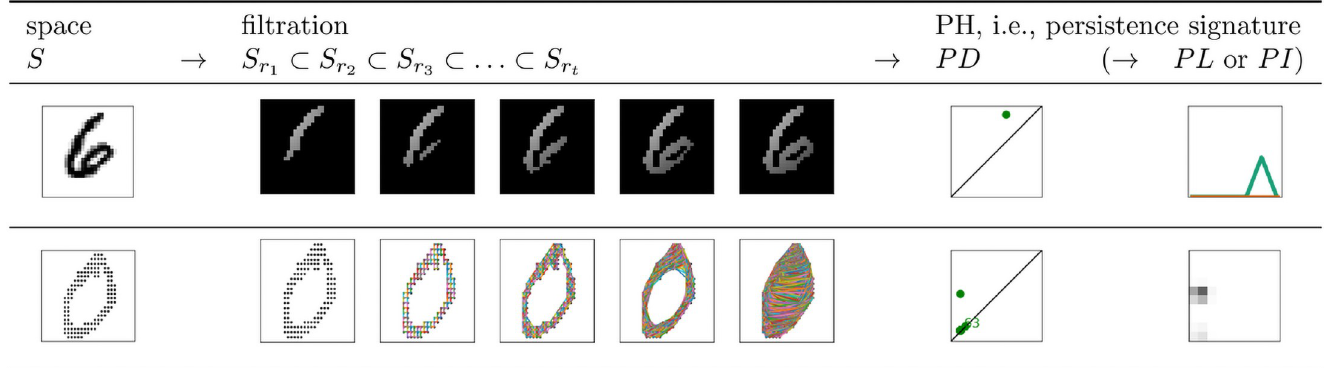
Fig 1. Persistent homology pipeline. PH can be calculated for different types of spaces S , which can represent a single data observation (typical for classification tasks) or a complete dataset. In this figure, we calculate the PH information for an image. The input for PH is a filtration, a nested family of spaces that approximate the structure of S at different scales r 1 < r 2 < ... r . For example, to approximate the structure of an image at scale r , we can look only at pixels within distance r from the t top left pixel (top panel). Alternatively, we can look at an image as a point cloud, and approximate its structure at resolution r by constructing an edge between two points whenever they are within distance r (bottom panel). For a homological dimension k (in the figure, k = 1), PH registers the birth and death time r of every k - dimensional cycle (connected component, loop, void, etc.) within the filtration, and is commonly summarized with a scatter plot of birth and death coordinates, referred to as persistence diagram ( PD ). It is often interesting or even necessary to transform the PD into a different persistence signature, such as a persistence landscape ( PL , top panel) or a persistence image ( PI , bottom panel).